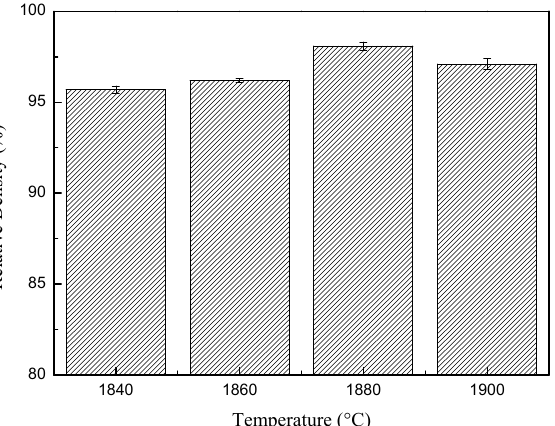
Figure 4. The relative density of the sintered uniform-layered sample under different temperatures.